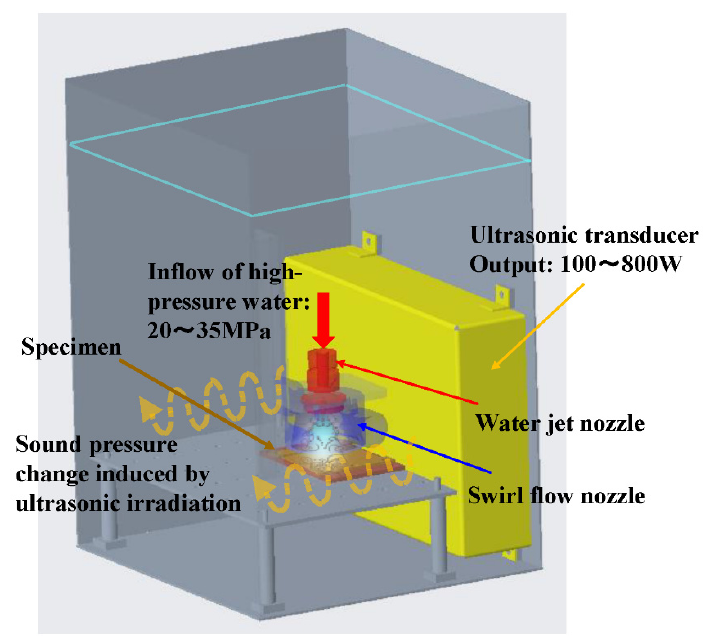
Figure 1. Schematic diagram of processing equipment for ultra-high-temperature and high-pressure cavitation (UTPC) and low-temperature and low-pressure cavitation (LTPC).